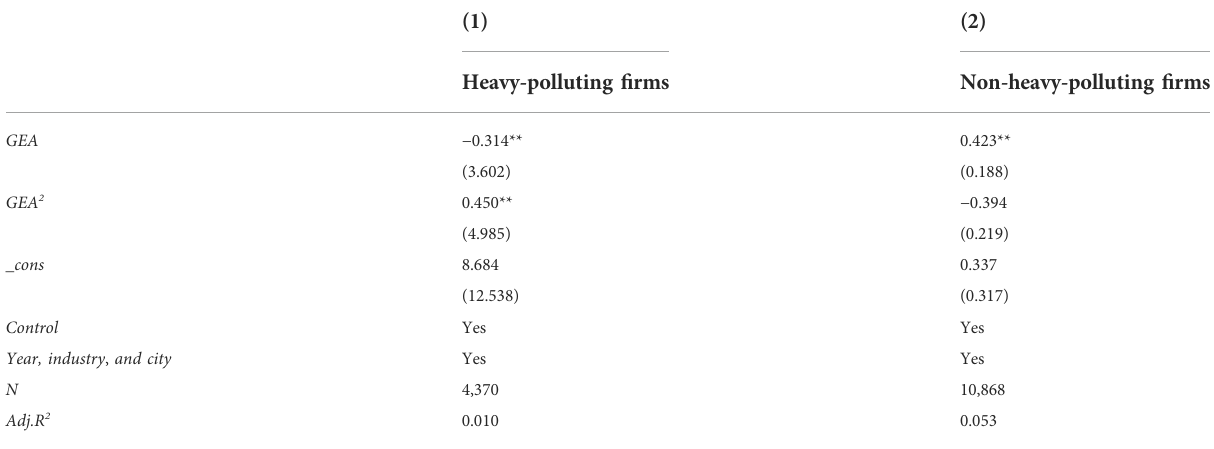
TABLE 9 Estimation results for excluding favorable environment